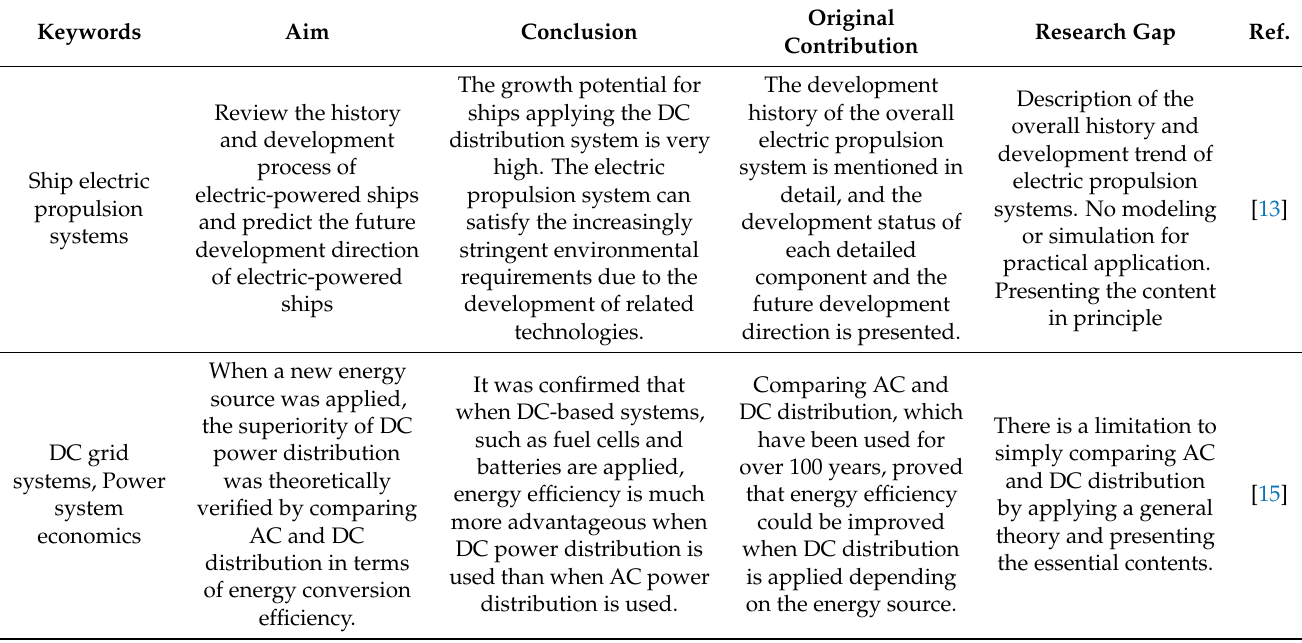
Table 2. Literature review of electric propulsion